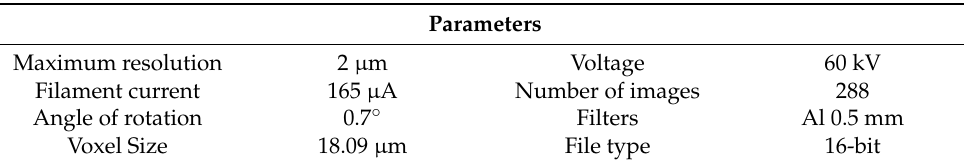
Table 1. Summary of the parameters used in the scanning